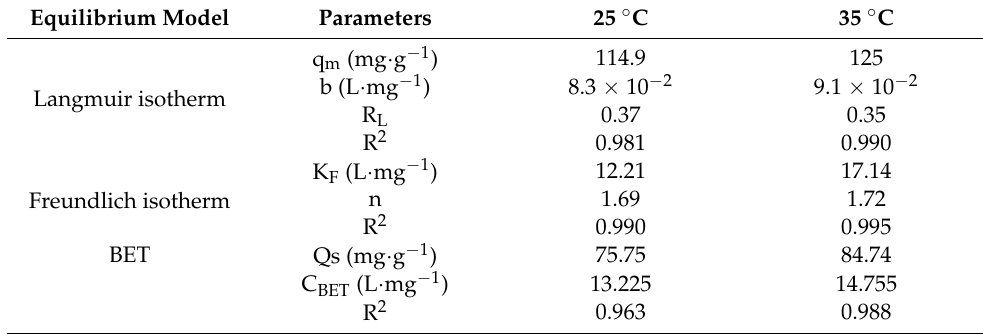
Table 2. Adsorption isotherm parameters.